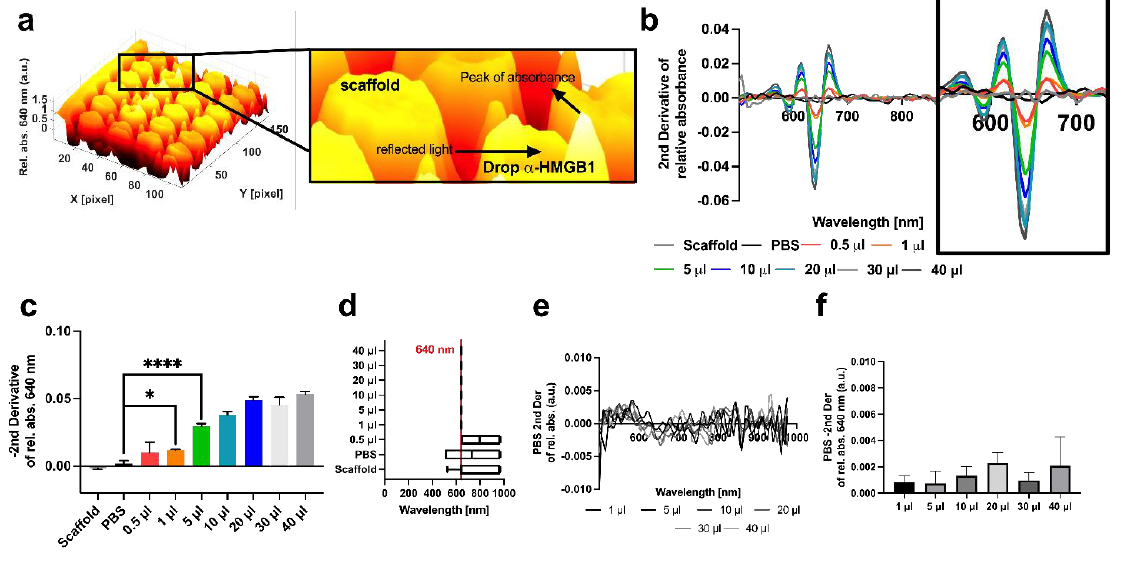
Figure 2. HSI Ab detection and volume size tests were performed as follows. ( a ) A drop of an- tibody 1:1 (antibody/PBS) was placed over the cover of a 96-well plate and HSI was performed. ( b ) Second derivative of relative absorbance in the selected ROI where the drops were placed. The analysis of the peak indicated a peak of absorbance at 640 nm after 1 mL. Each signal is an average of 4 drops. ( c ) The second derivative of relative absorbance showed peaks at 640 nm propor- tional to volume. The maximum significant increase was found at 5 mL ( p < 0.0001), after which the p -value did not change. ( d ) The statistical analysis showing the minimum volume detectable was 0.5 mL, where a signal/volume plateau phase was found after 20 mL (7 different volumes were tested ( e , f ) The PBS volume/signal test showed that the PBS volume did not significantly contribute to the signal at 640 nm. Data are presented as mean +/ − s.d. and compared to the scaffold